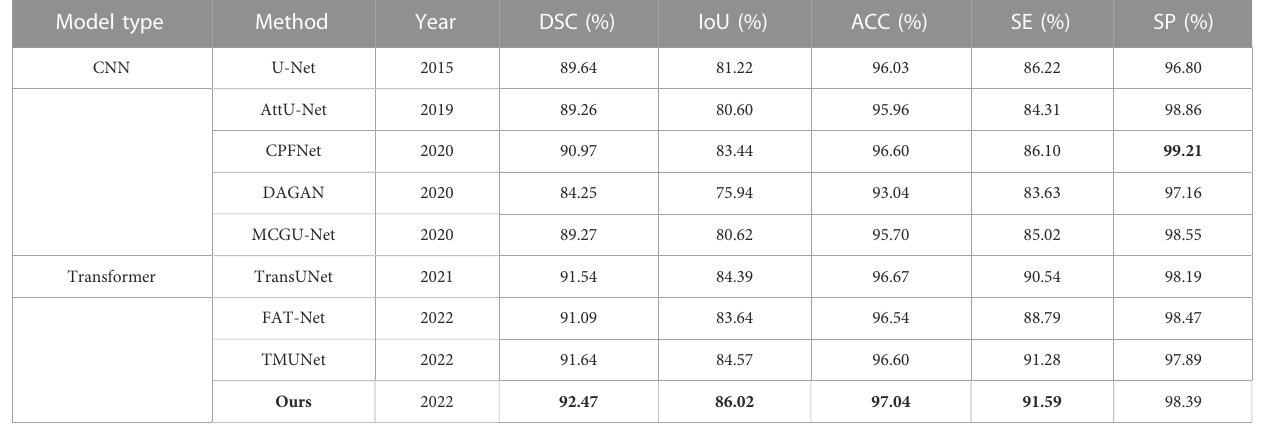
TABLE 5 Statistical comparison of the segmentation results on ISIC 2017. The best results are shown in bold. Model type